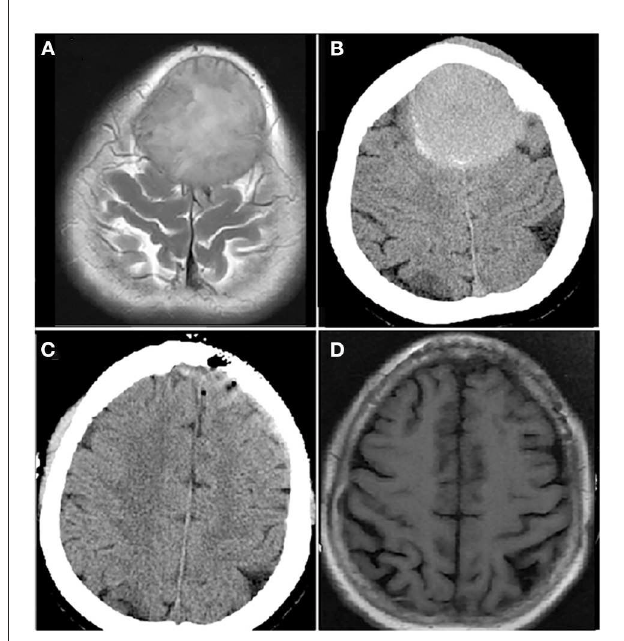
FIGURE3 Computer tomography (CT) and magnetic resonance imaging (MRI) brain images from a female patient present with bilateral frontal mass. Enhanced MRI brain image (A) and CT brain image (B) at diagnosis showed a mass of 5.3 × 7.0cm in bilateral frontal lobe; CT brain image after resection of bilateral frontal lobe mass, the mass disappeared (C) ; MRI brain image before autologous hematopoietic stem cell transplantation (auto-HSCT), no mass in bilateral frontal lobe (D)